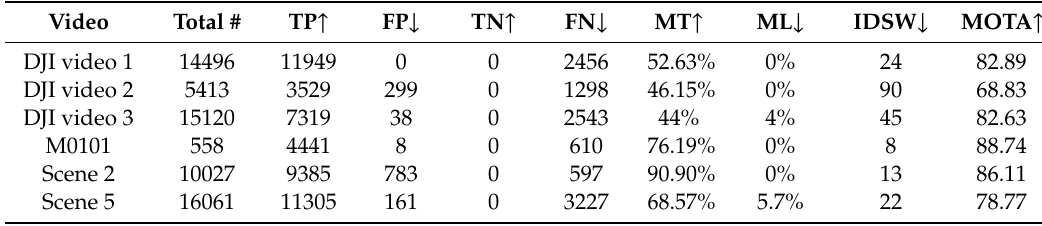
Table 3. The evaluation metrics of multi-vehicle tracking from UAV